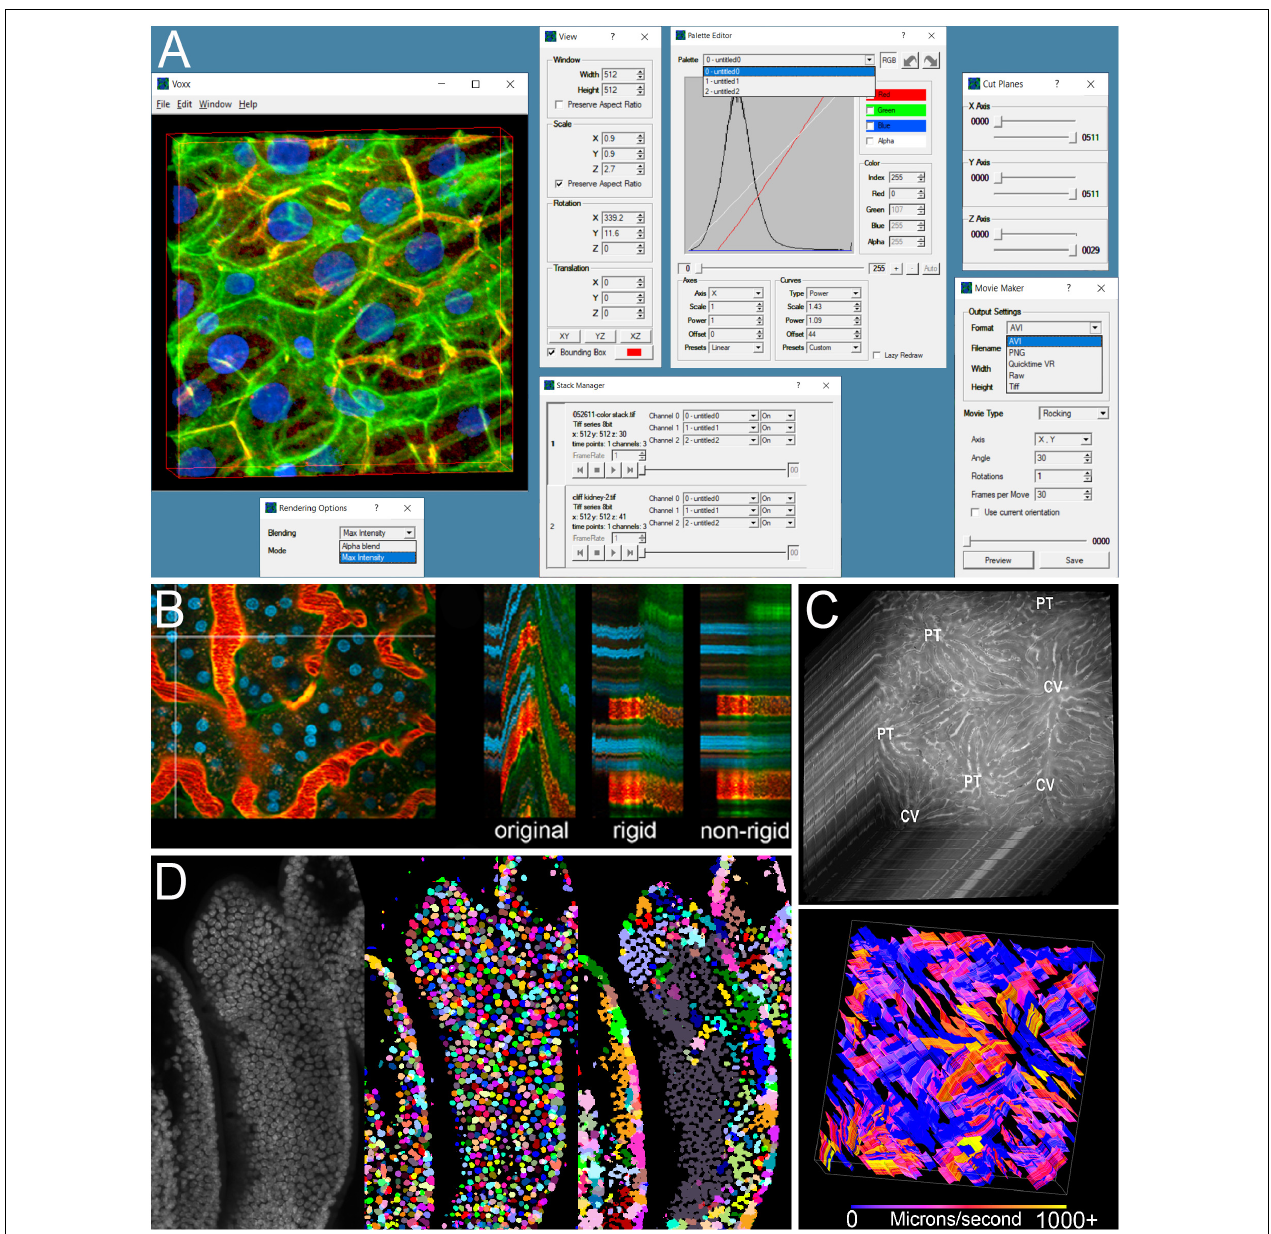
FIGURE 1 | Examples of image processing software developed by the Indiana O’Brien Center. (A) Screenshot of Voxx volume visualization software showing the rendered volume, and interactive windows for selecting rendering method, adjusting view and channel palette settings, selecting between multiple volumes, limiting the volume to be displayed, and setting parameters for video outputs. (B) Example of IMART image registration. Left – first of a series of images collected over time from the kidney of a living rat. Vertical line indicates region used to generate YT images (two-dimensional images that show the image of a single line, oriented vertically over time, and oriented horizontally). Right – YT images from the original time series, after rigid registration and after rigid and non-rigid registration. (C) Example of STAFF microvascular velocity measurements. Top – Series of images collected at the rate of 97.5 frames per second from the liver of a living rat following injection of a fluorescent dextran. Bottom – map of velocities measured over time in which time is presented as a third dimension. (D) Comparison of nuclear segmentation results obtained from a 3D volume of mouse intestine (left), using DeepSynth (middle) or CellProfiler (right). Images shown in panels (B–D) are modified from previous publications (Dunn et al., 2014, 2019; Clendenon et al., 2019b) and used with